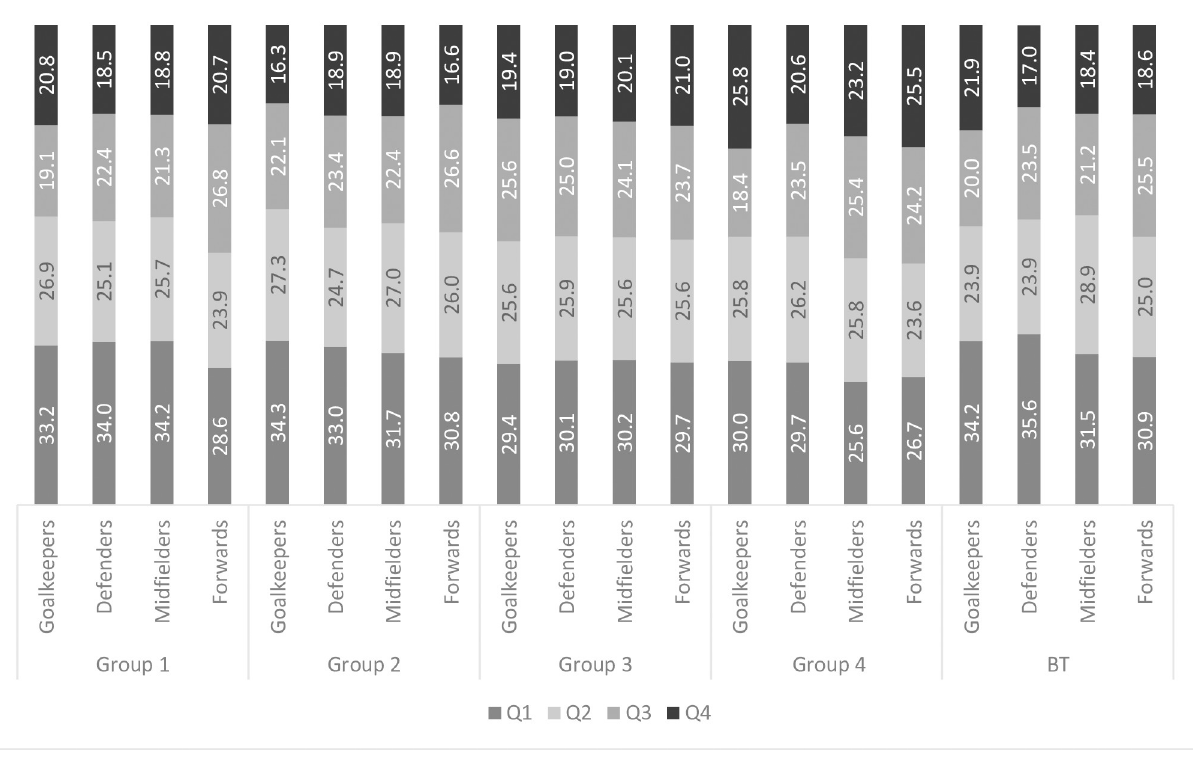
Fig 3. Relative Age Effect by playing position